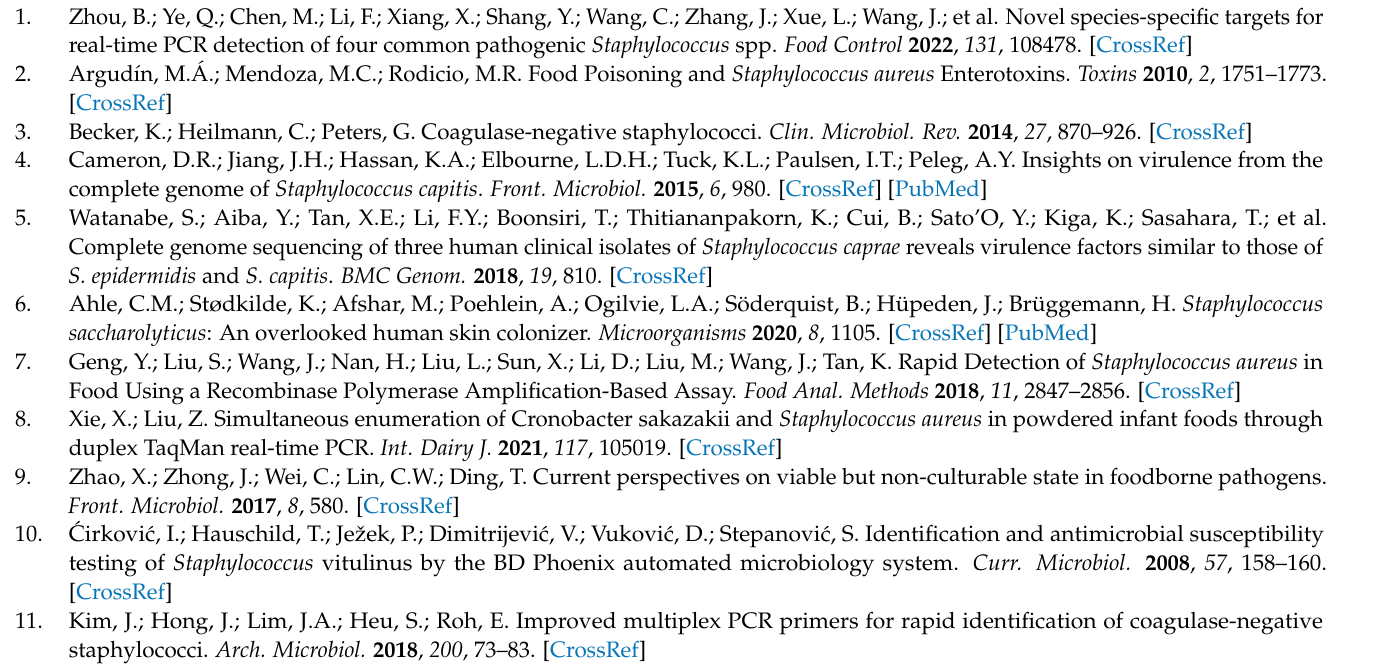
Table S2: Presence of novel and reported molecular target genes for target and non-target genomes, Table S3: Specificity of the designed primer pairs using primer-BLAST